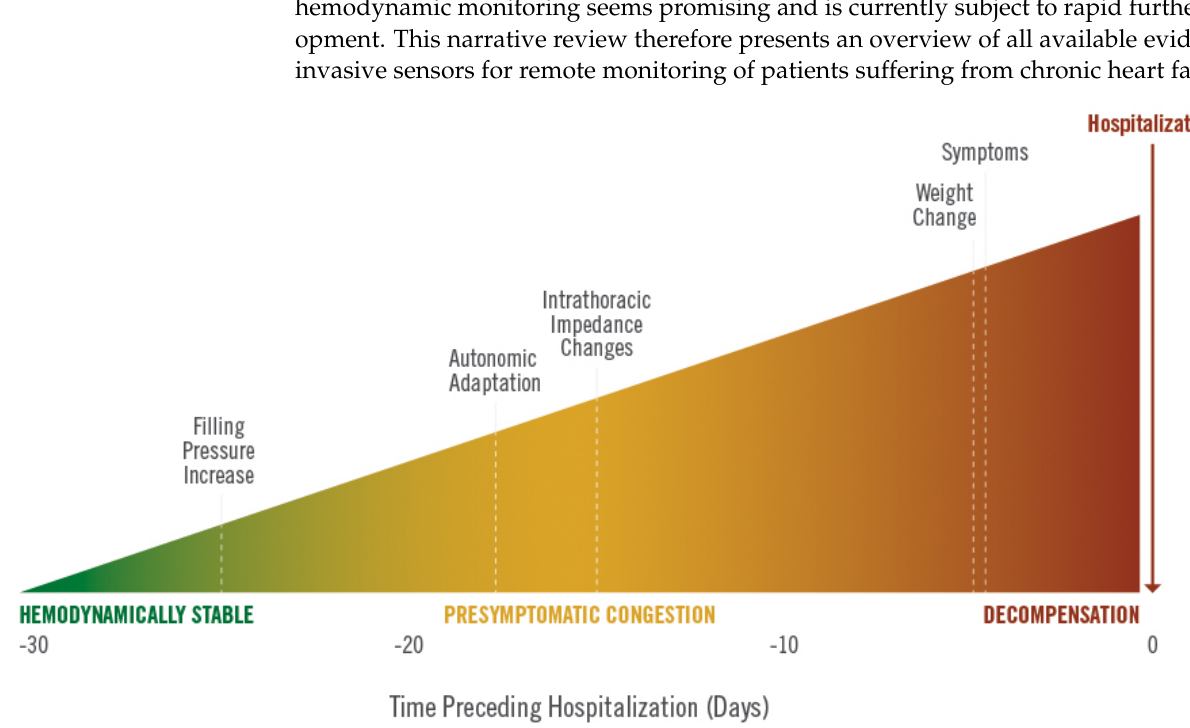
Figure 3. Pathophysiology of congestion. Graph adapted from Adamson PB, Pathophysiology of the transition from chronic compensated and acute decompensated heart failure: new insights from continuous monitoring devices. Current Heart Failure Reports 2009, 6, 287–292 [9]. Reprinted with permission from Abbott Inc. (Abbott, Sylmar, CA, USA).